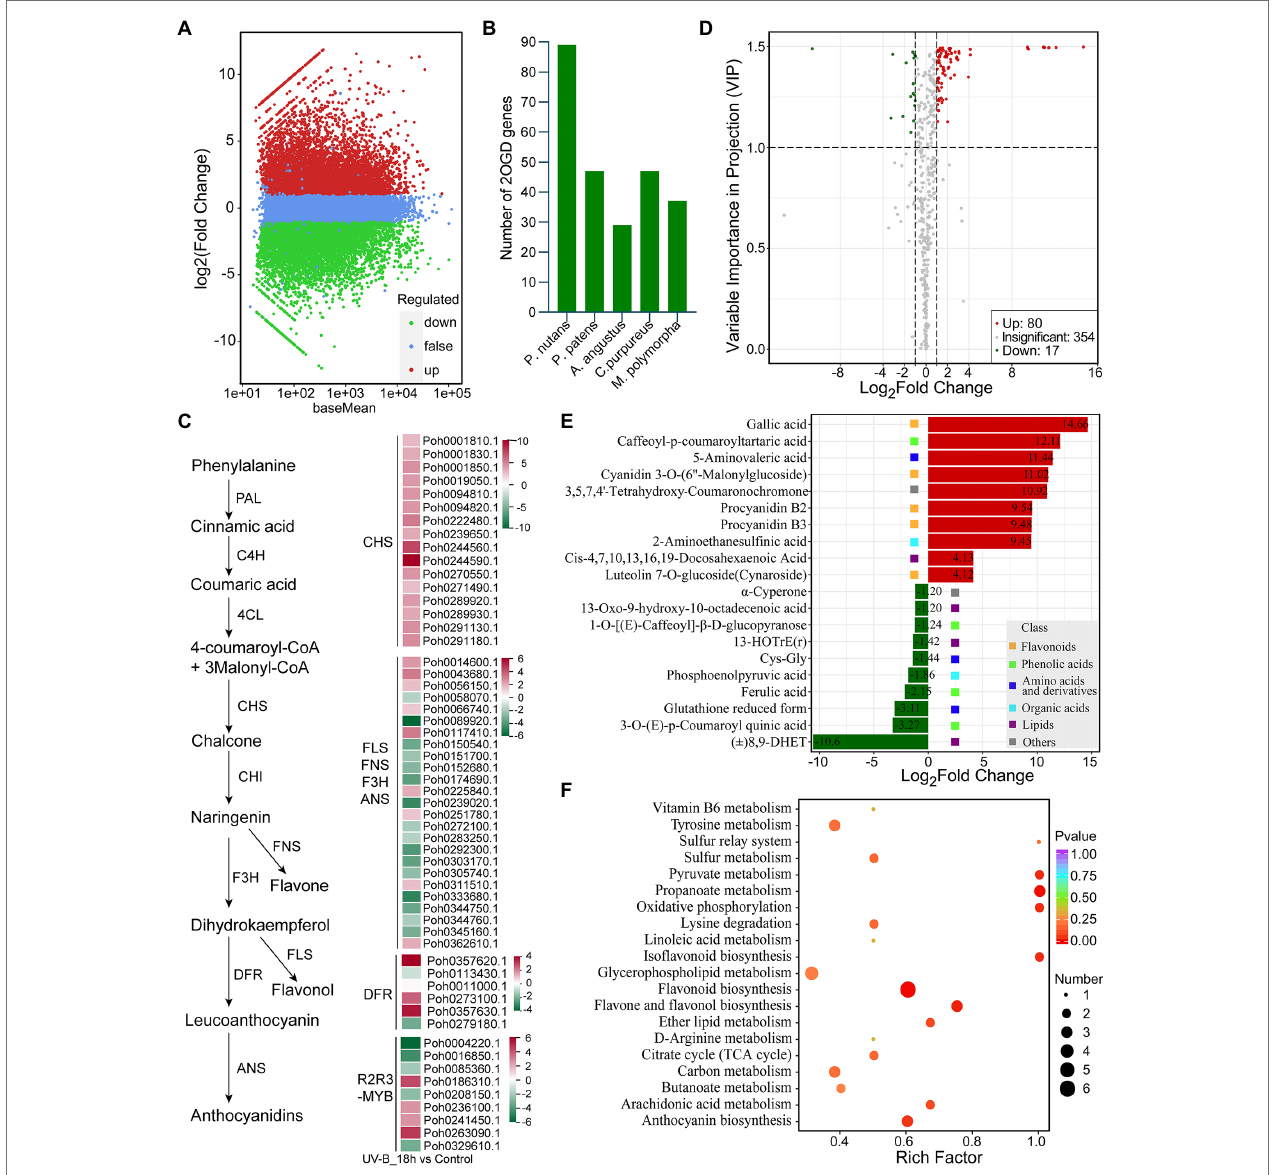
FIGURE 5 | Integrated multi-omic analyses reveal the role of flavonoid pathway under UV-B light. (A) The volcano plot showing the DEGs between UV-B radiation group and control group. The Y -axis indicates fold change of gene expression (threshold, |log 2 (Treat/Control)| > 1), while the X -axis means the statistically significant level (threshold, q -value < 0.05). (B) The gene family of 2-oxoglutarate-dependent dioxygenase (2-OGD) was expanded in the Pohlia nutans genome. (C) Flavonoid biosynthesis pathway genes were markedly upregulated under UV-B radiation detected by transcriptome sequencing. (D) The volcano plot showing the contents of metabolites and the statistical significance. Each point represents a metabolite. Horizontal ordinate indicates the fold change of metabolites between two groups, while VIP value represents significant difference in statistical analysis. (E) The fold change of the top 20 significantly changed metabolites (SCMs) between two groups. (F) Statistics of KEGG enrichment for the